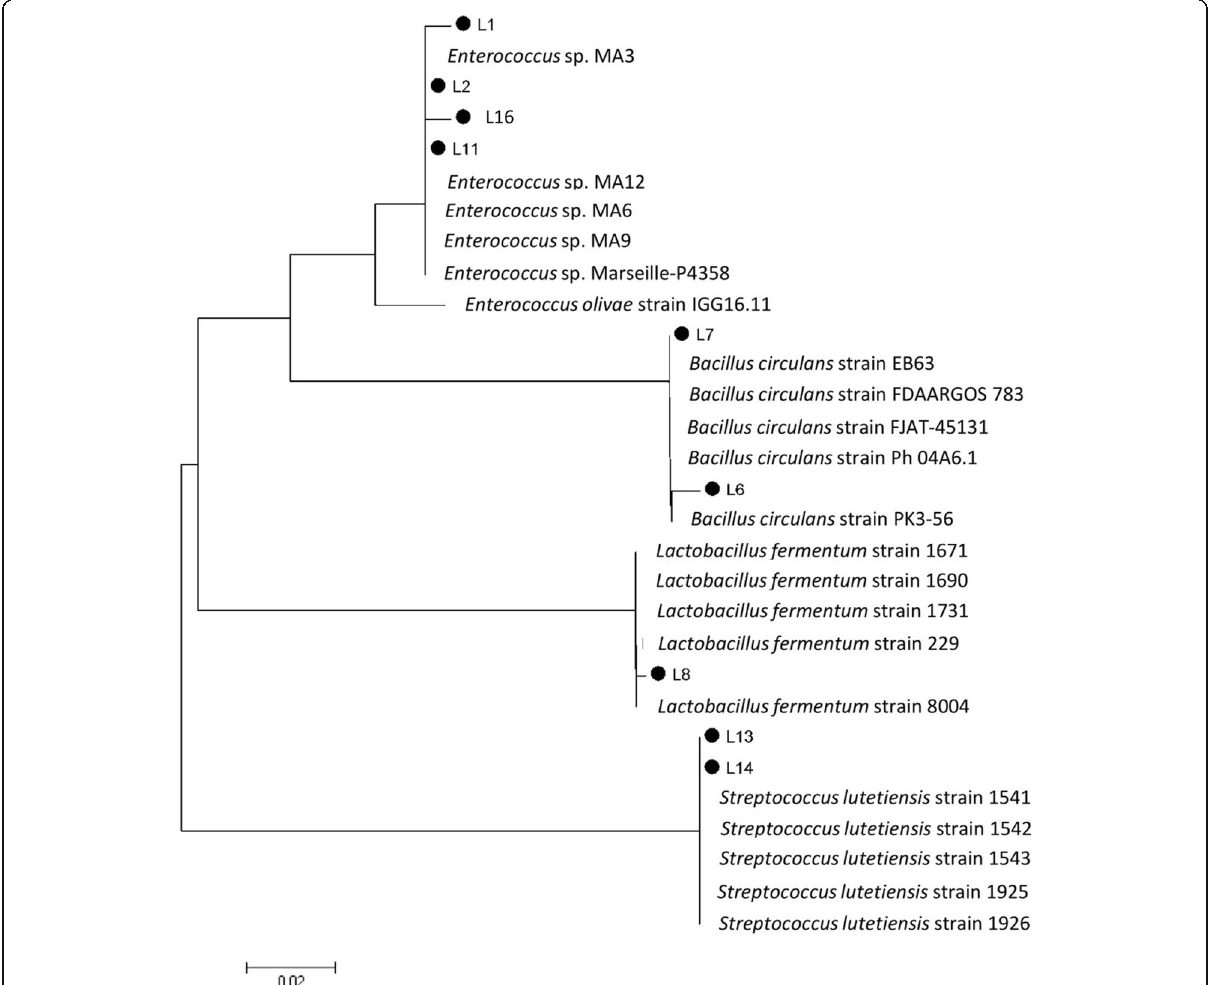
Fig. 2 A neighbor-joining phylogenetic tree based on 16S rRNA gene sequences of 9 LAB isolates (dark circles) with the closest hits obtained from the NCBI